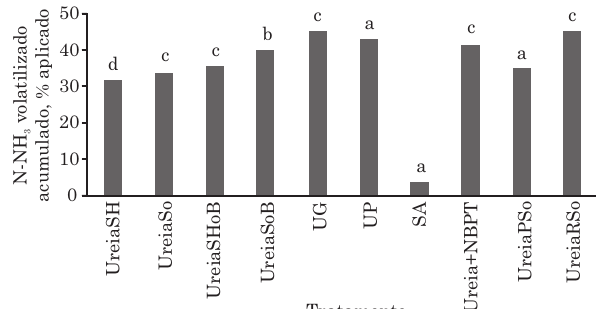
Figura 3. Perdas acumuladas por volatilização de N-NH 3 provenientes dos fertilizantes compactados de ureia com fontes de enxofre e bentonita após 21 dias de avaliação. Médias seguidas de letras distintas diferem entre si pelo teste de Scott- Knott a 5 %.